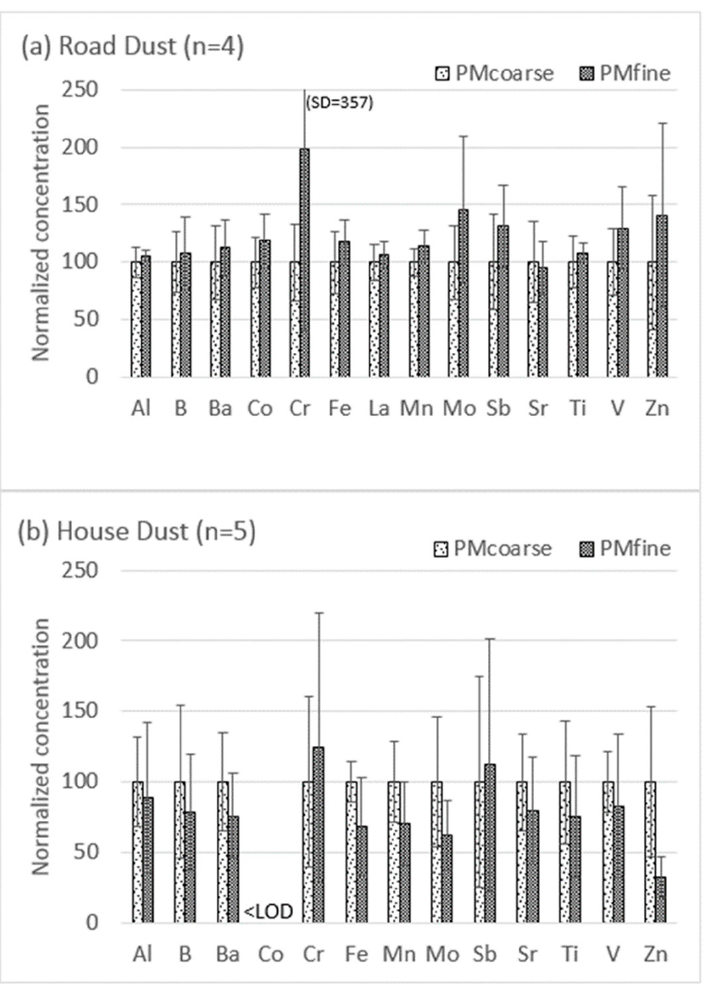
Figure 2. Normalized total metal concentrations in fine versus coarse fractions of ( a ) road dust and ( b ) house dust. For each element, the coarse fraction was normalized (to 100), with the fine fraction converted proportionately. Fine = <1.8 µm and coarse = 1.8–10 µm; error bars show normalized standard deviations (see supplementary material Table S1 and Table S2 for all original data).